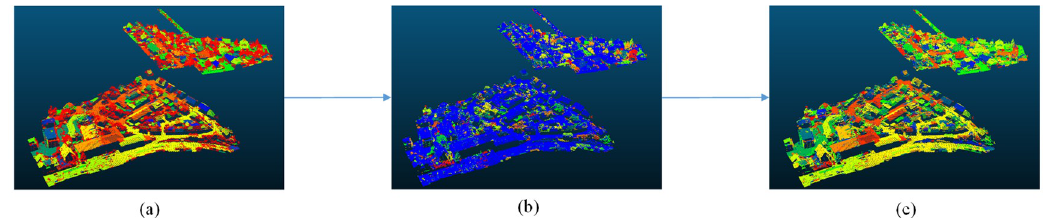
Figure 1. The three-step region growing method: ( a ) planar object extraction, ( b ) small pieces re-segmentation, and ( c ) merging.